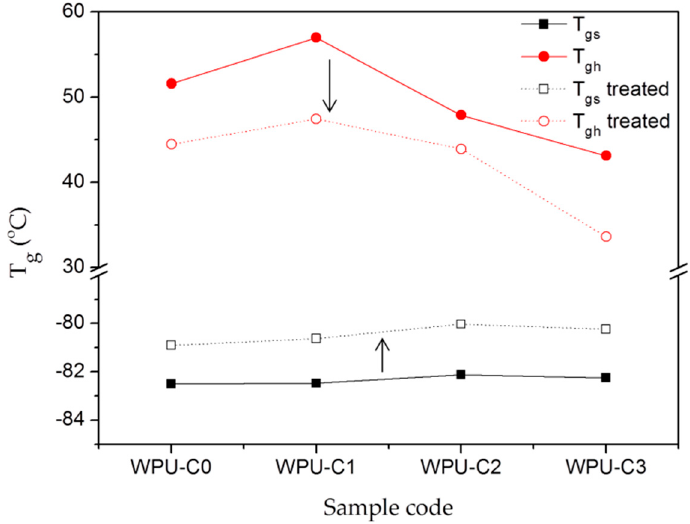
Figure 4. The thermal properties of different waterborne polyurethanes (WPUs) before (solid line) and after (broken line) heat treatment for 24 h at 110 ° С .